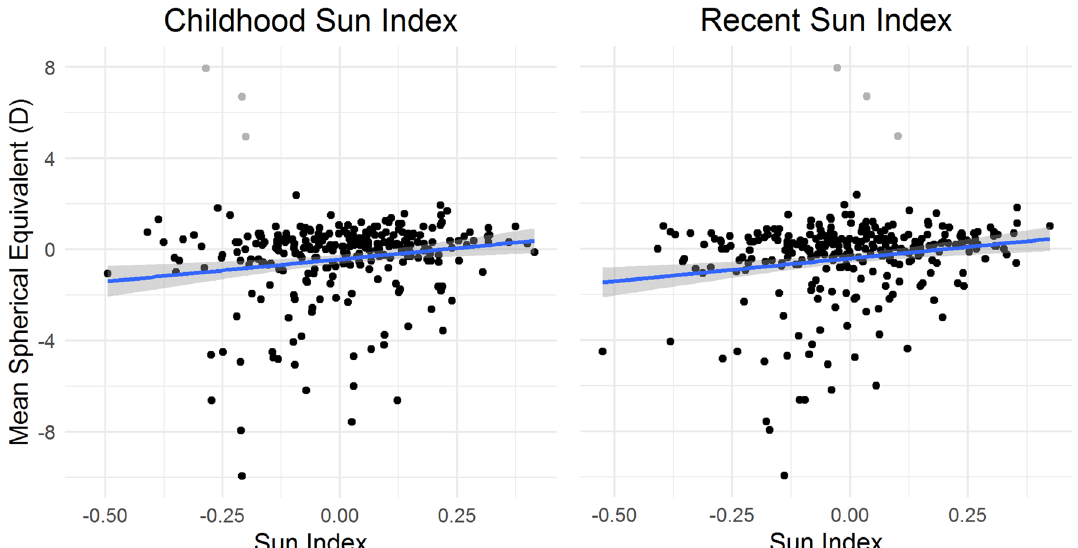
Figure 3. Plots of spherical equivalent over childhood (left) and recent (right) sun indices. The blue line represents the simple linear regression line and grey shading represents 95% confidence intervals. Data from three individuals with moderate to high hyperopia (grey points) were excluded when calculating the linear regression equation and 95% confidence interval. Figure drawn using the ‘ggplot2’ package in R v3.5.1